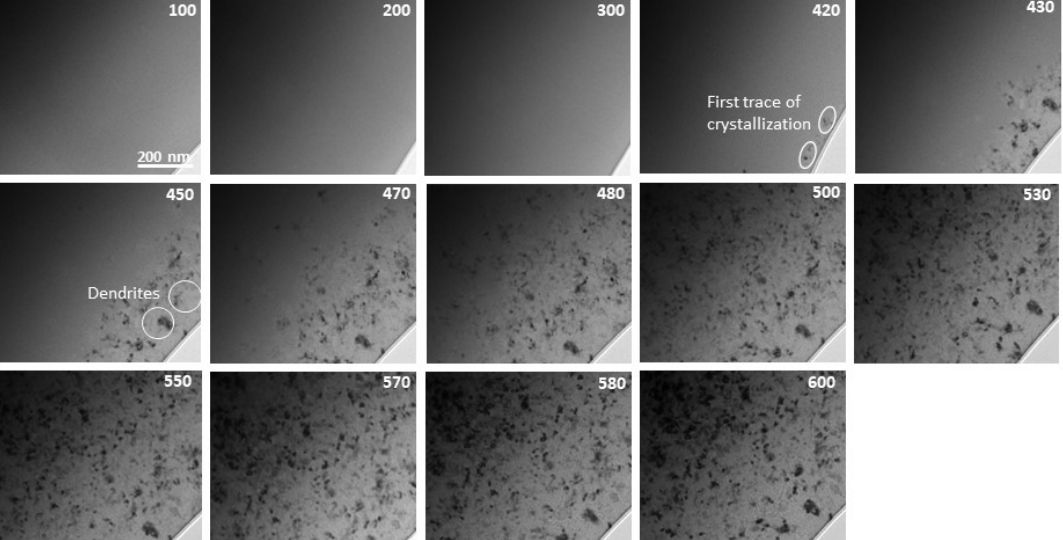
Figure 4. The X-ray diffraction patterns of Fe 84.5 − x Co x Nb 5 B 8.5 P 2 ribbons in as-spun state.